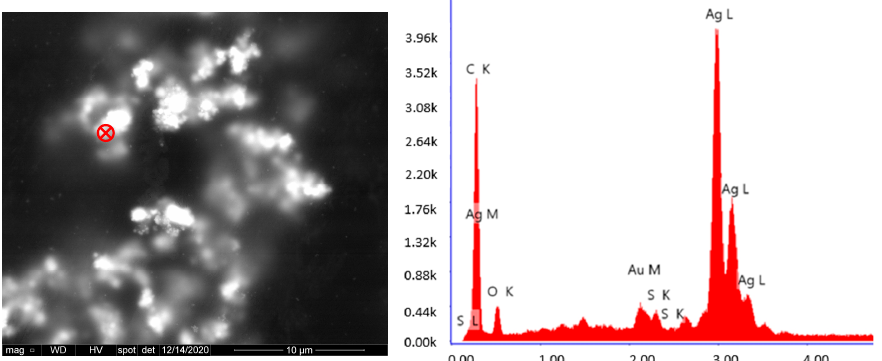
Figure 3. SEM image of acrylic latex containing AgNPs ( left ) and energy dispersive spectroscopy spectrum of the red marker ( right ).